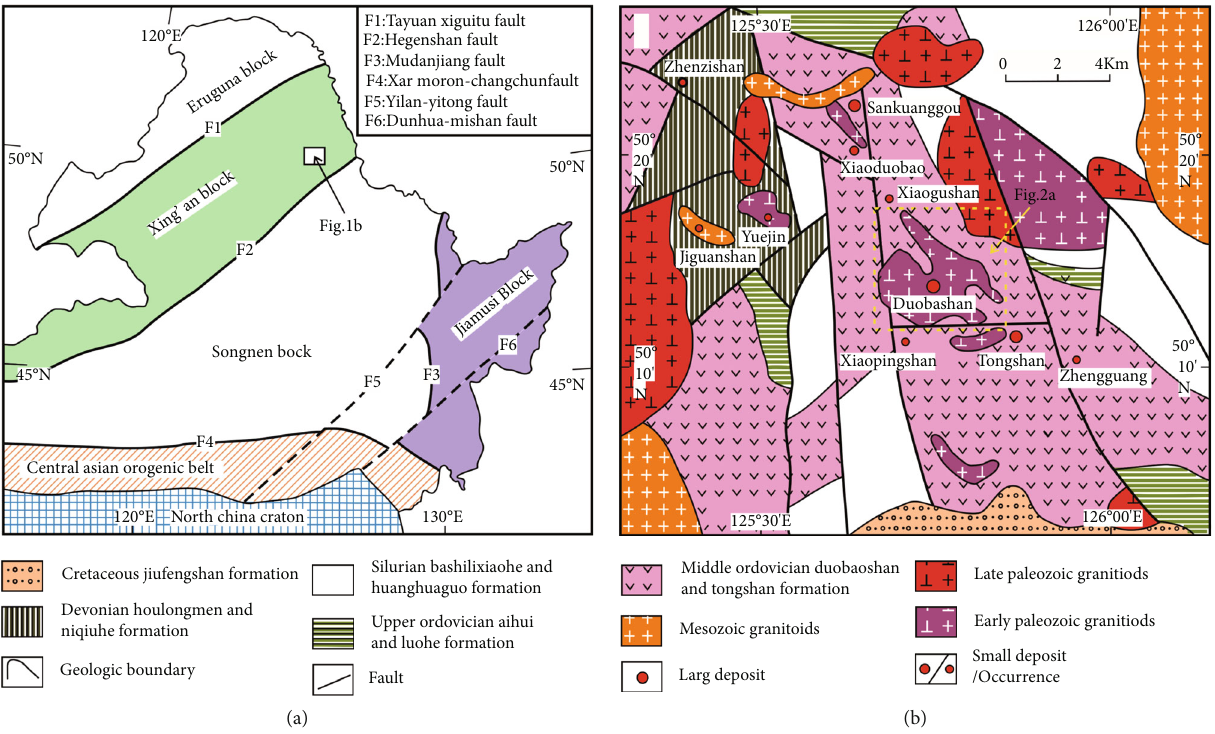
Figure 1: Sketch tectonic map (a) and regional geological map (b) of the Duobaoshan porphyry Cu (Mo) deposit [7, 20].